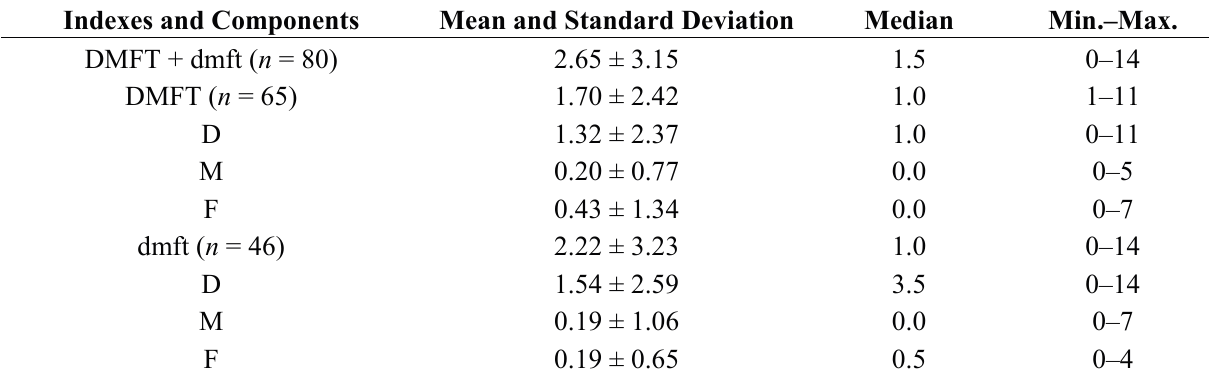
Table 3. DMFT and dmft indexes and components, measured in children and adolescents with CP. Indexes and